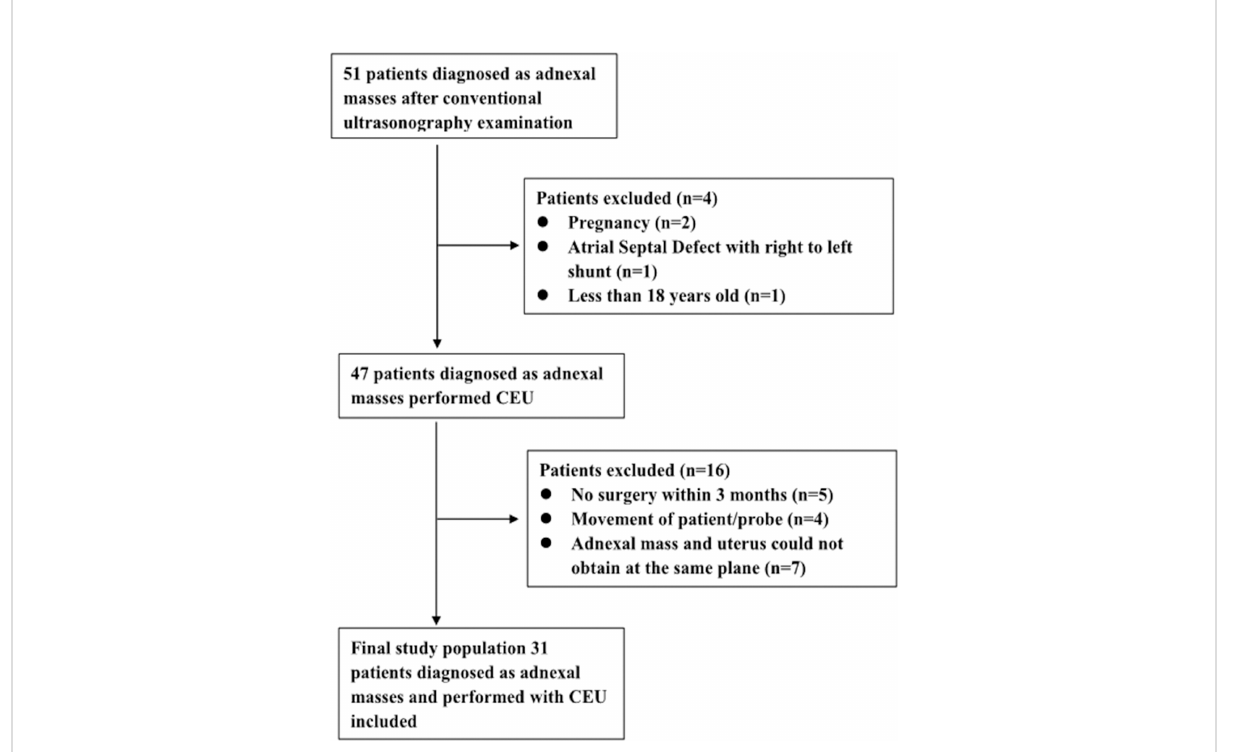
FIGURE 1 Flowchart for selection of patients with adnexal mass. In total, 31 out of 51 patients were included according to the selection